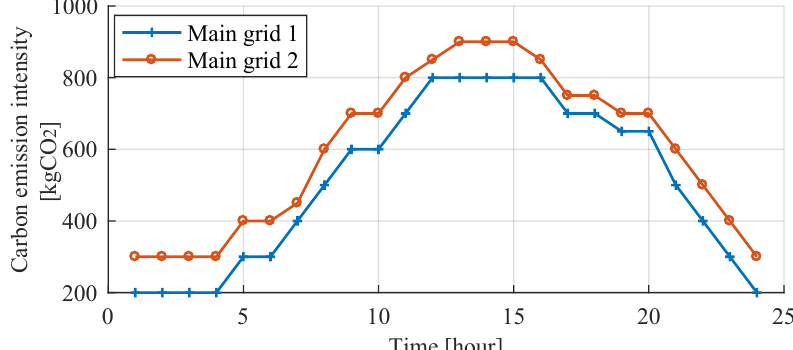
Figure 4. Carbon flow intensity of the main grids.